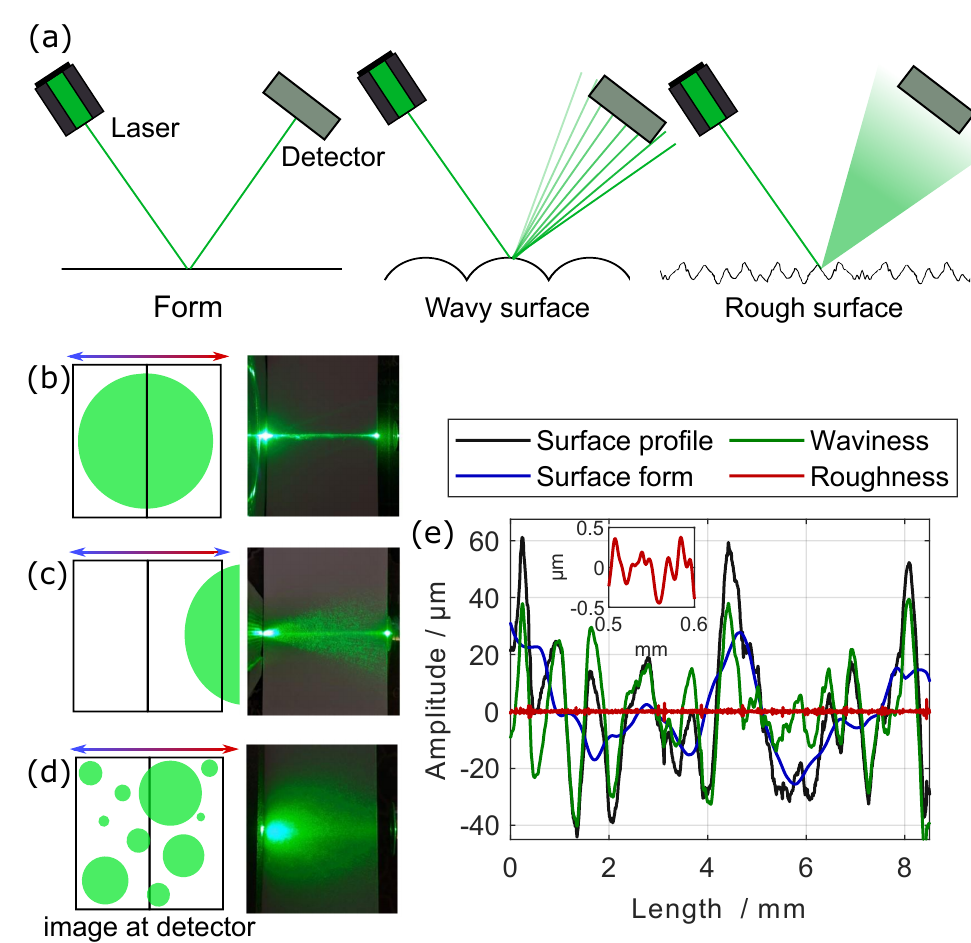
Figure 1. ( a ) Diagrams illustrating how light reflects off a smooth surface where the form is such that it appears locally flat to the detection (left), a wavy surface (middle), and a rough surface (right). ( b ) diagram showing the centred beam returned to the detector from the smooth surface reflection, and a photographs of a green laser reflected off the surface of an optically smooth surface (left). ( c ) shows the beam reflecting at a different angle from a wavy surface and photograph showing the light returned from a WAAM sample. ( d ) shows the speckles on the detector from the fine-scale rough surface, and the L-PBF sample shows the effect on the detection laser. ( e ) decomposition of surface profile (black) of an as-deposited L-PBF specimen into the three regimes of roughness: form (blue), waviness (green), and roughness (red). The inset figure shows a zoom of the roughness value across of length of 100 µ m—on the order of the diameter of the detection spot size of the rough surface SRAS